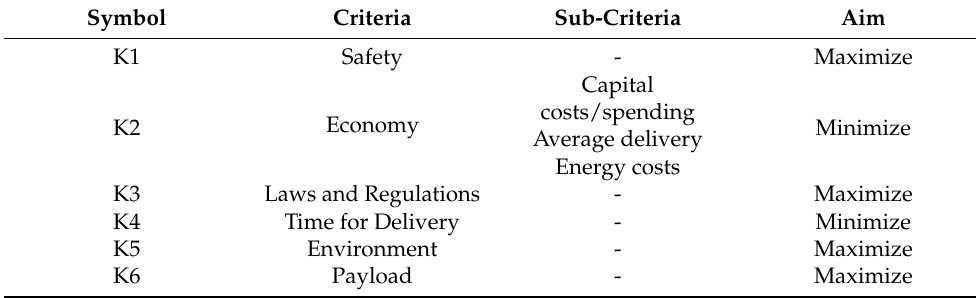
Table 1. Criteria Ranking and